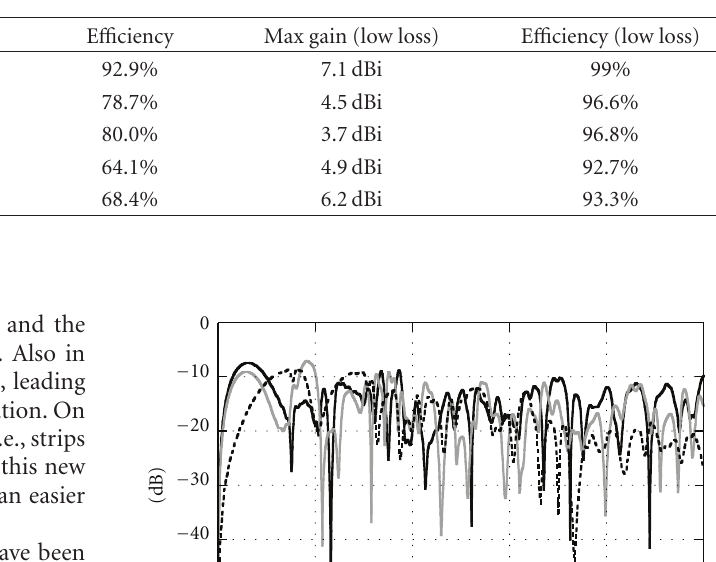
Table 1: Maximum gain: on ϕ = 0 ◦ .